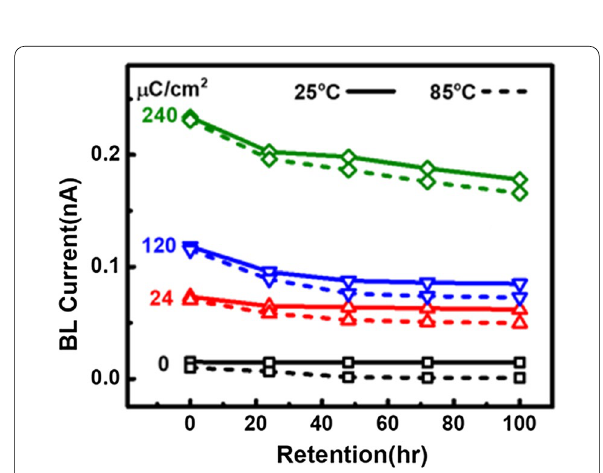
Fig. 8 The e‑beam sensing results can be stored in the proposed detector and data remains relatively stable for days, enabling off‑line on‑wafer read out